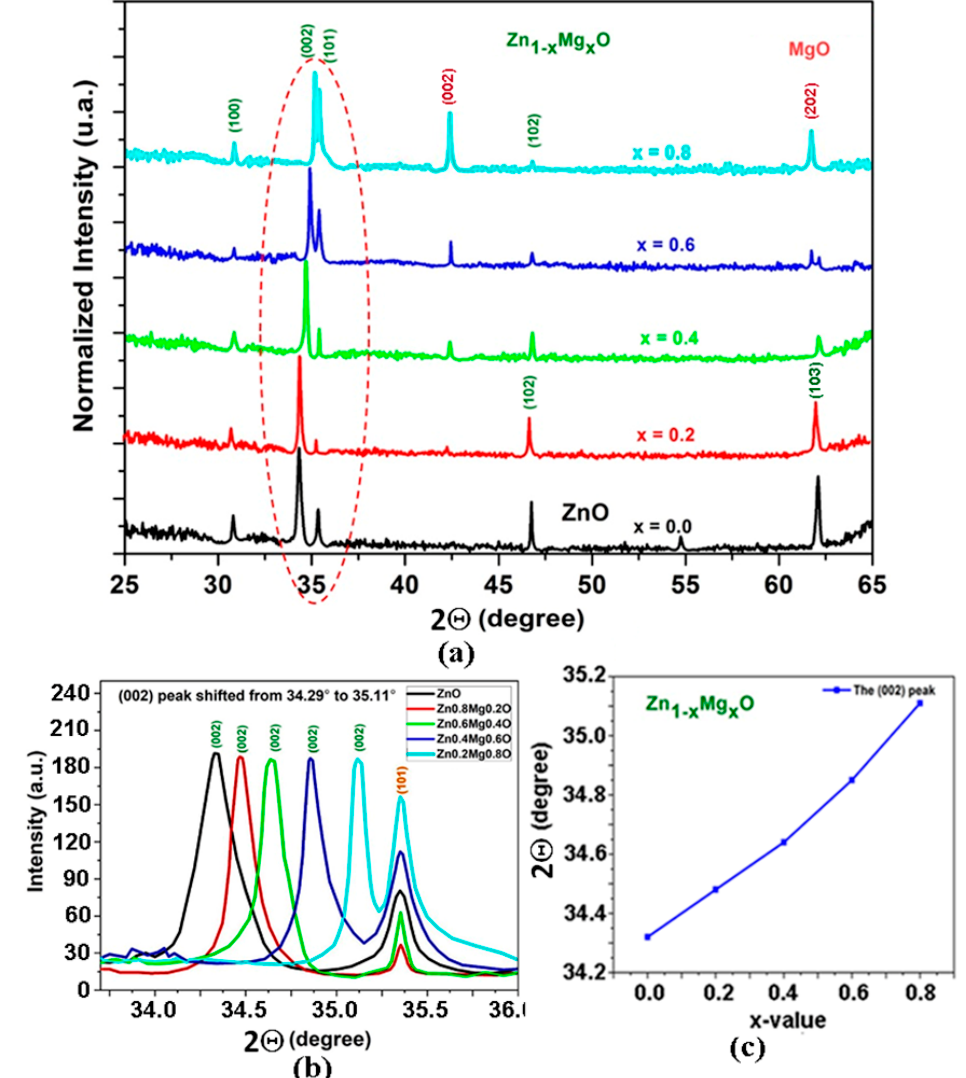
Figure 4. ( a ) XRD pattern of Zn 1 − x Mg x O films deposited by spin coating. ( b ) Evolution of the (002) reflex in the wurtzite phase with increase of the x value. ( c ) Dependence of the position of the (002) reflex on the x value.